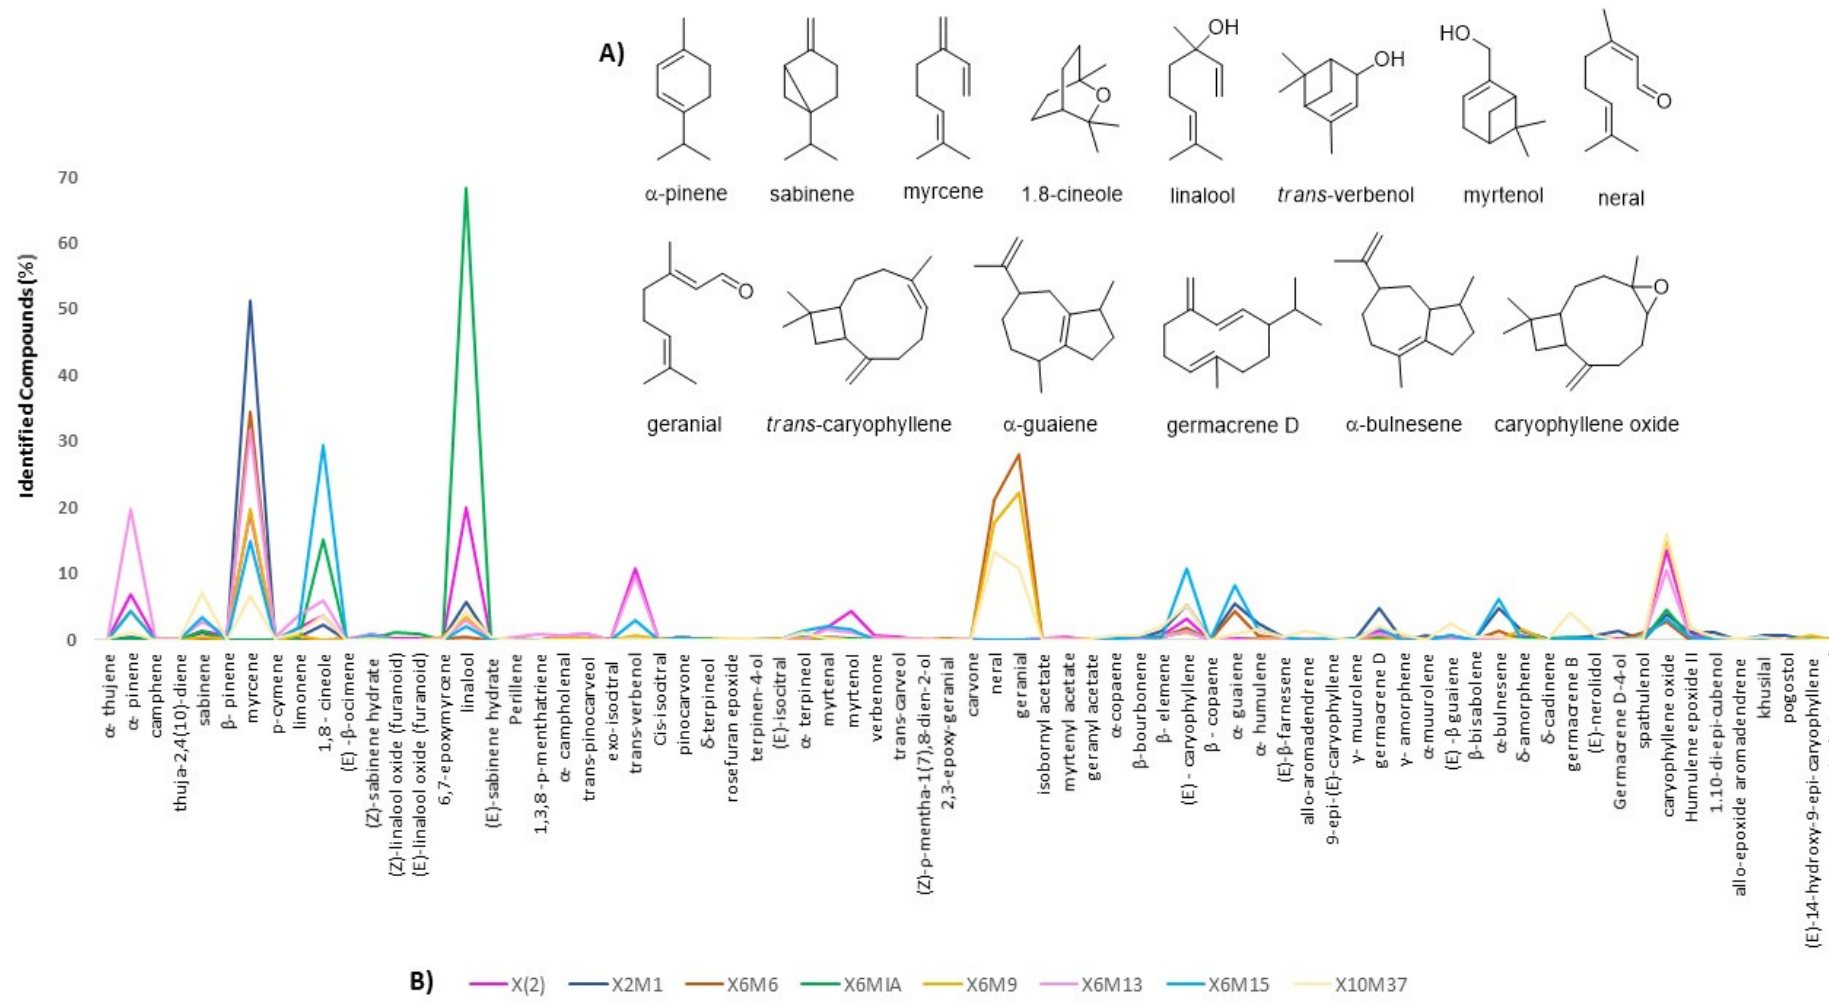
Figure 2. ( A ) Structure of the main compounds found in the new genotypes of L. alba . ( B ) Identified compounds and comparison of their distribution (relative abundance) among all genotypes.